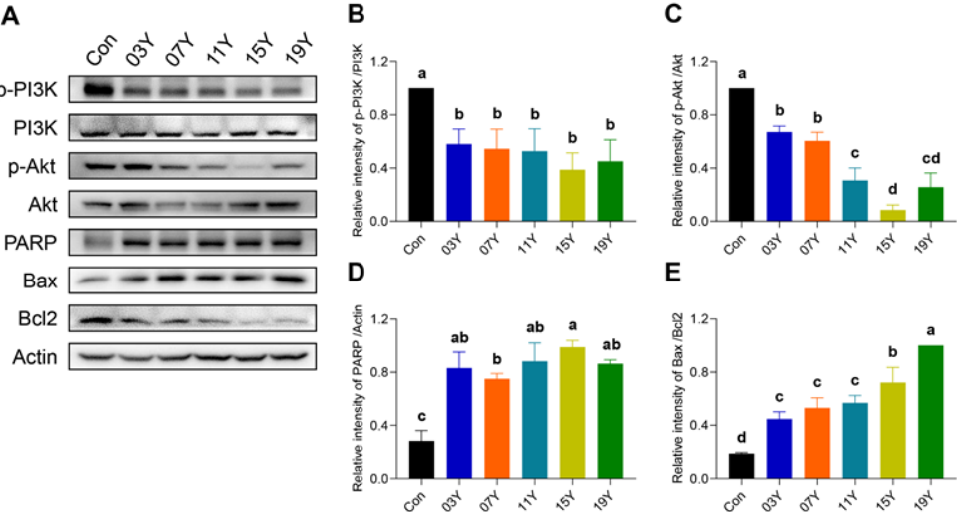
Figure 5. The tea extract inactivated PI3K/AKT signalling and enhanced apoptotic pathways. ( A ). HT-29 cells were treated with 0.2 mg/mL extracts of different tea samples 03Y , 07Y , 11Y , 15Y and 19Y for 48 h, followed by detection of p-PI3K, p-AKT, PRAP, Bax and Bcl2 expression by Western blotting. ( B – E ) Relative quantification of p-PI3K, p-AKT, and PRAP protein levels (with actin as references) and Bax/Bcl2 ratio in each group was shown. One-way ANOVA analysis was performed between the treatments of multiple tea samples. The different lowercase letters (a, b, c, d) in the same group show the significant differences at p < 0.05 level.